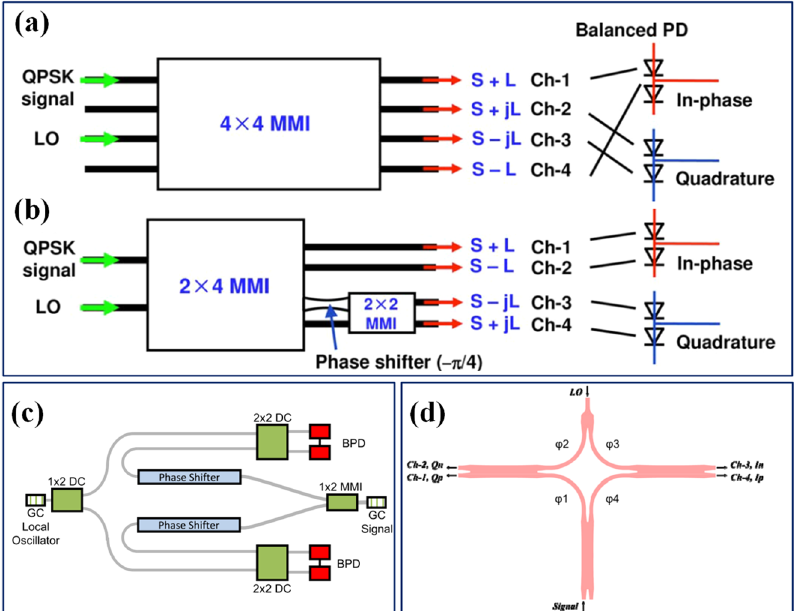
Figure 9: Schematic diagram of (a) optical hybrid based on a 4 × 4 MMI and (b) optical hybrid based on a 2 × 4 MMI serially connected with a 2 × 2 MMI [105]; (c) optical hybrid based on 1 × 2 MMI, 2 × 2 MMI, and phase shifters [102]; (d) optical hybrid comprising one Y -junction and three 2 × 2 MMIs